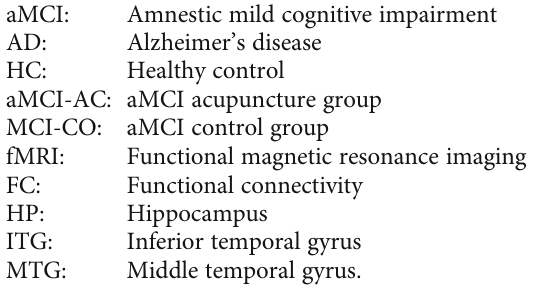
Supplementary Table 1: clinical characteristics of subjects with amnestic mild cognitive impairment (aMCI) and healthy control (HC). (Supplementary